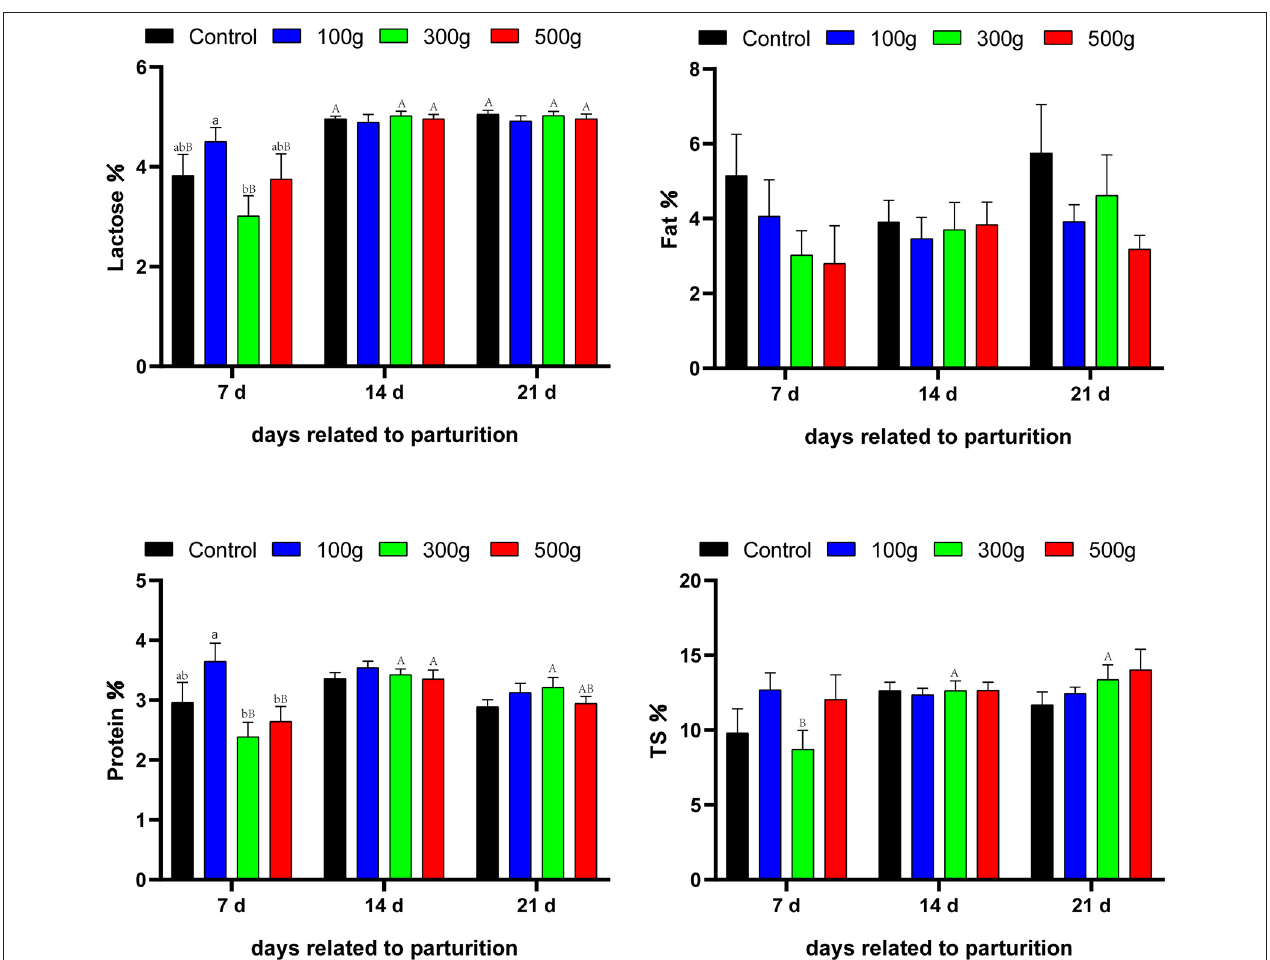
FIGURE 3 | Effects of dietary TCMF4 on milk composition in peripartal dairy cows. The milk components from the experimental cows were measured on day 7 before calving, day 1 before calving, and days 7, 14, and 21 after delivery. The control group was fed a basic diet; TCMF4 groups (control diet supplemented with TCMF4). a,b Different superscripts within a row represent significant differences between groups ( P < 0.05). A,B Different superscripts in the rows represent significant differences in time ( P <